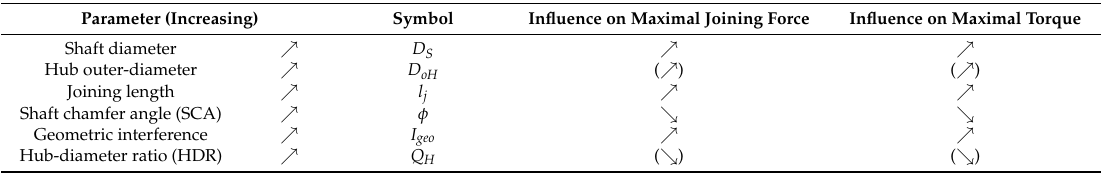
Table 1. Parameters that influence knurled interference fits: (cid:37) represents a larger influence with an increasing parameter; (cid:38) represents an opposed influence with an increasing parameter, ( ) represents a hypothesized influence.